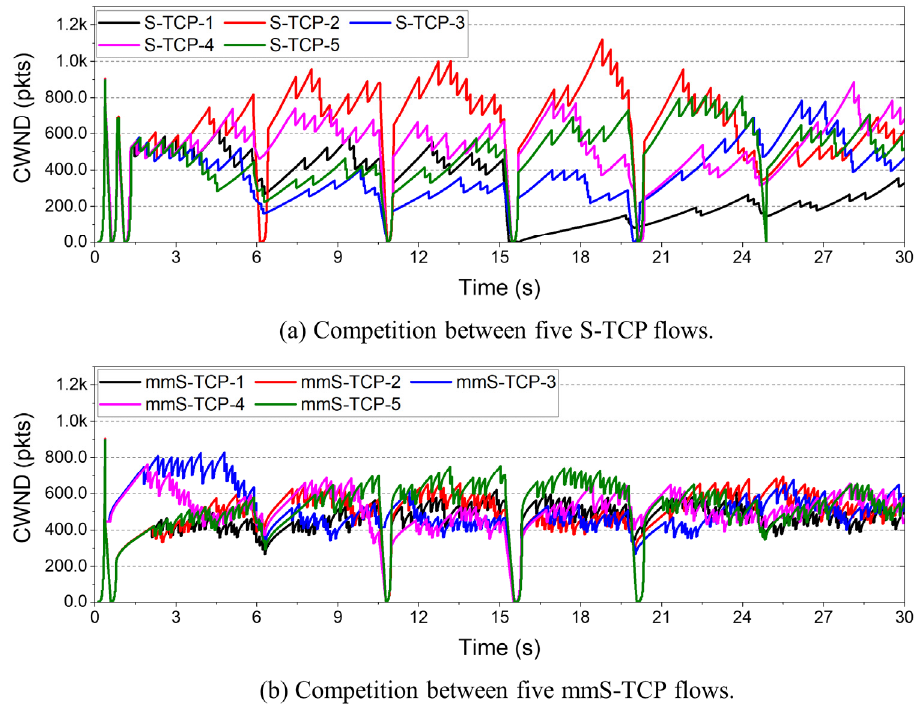
Figure 13. Cwnd changes in competition between five flows: ( a ) S-TCP; ( b ) mmS-TCP.